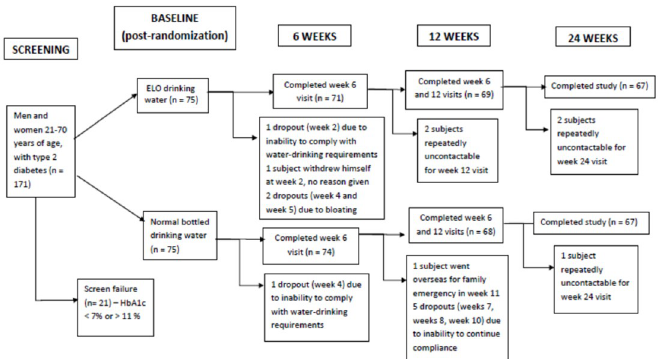
Fig 1. Flow chart of study recruitment and dropouts. Subjects had been advised that they would be able to withdraw from the study at any time. They were contacted at least a week before their next study appointment. Phone and/or SMS reminders were also given the day before their appointment.